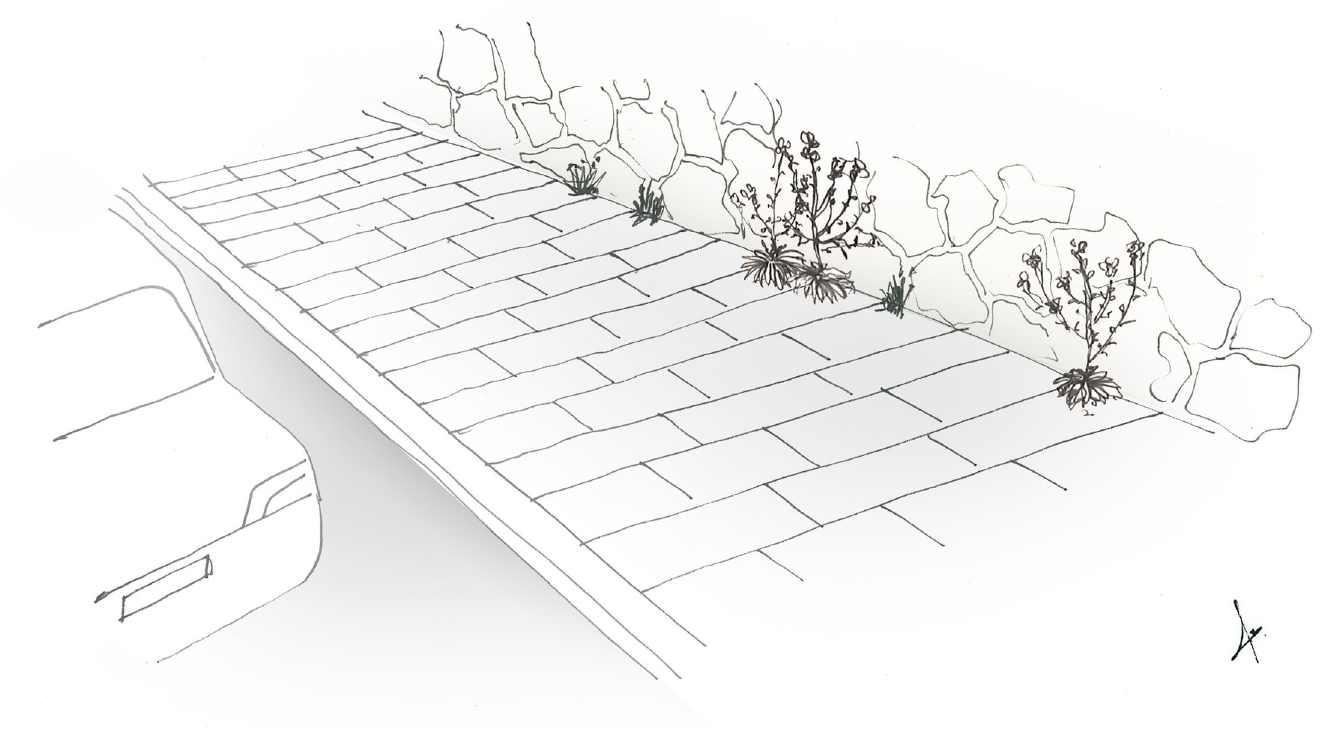
Fig 5. Illlustrated scene for sidewalk functioning as a habitat analogue for M . crassifolia . The cracks in the concrete of the sidewalk due to poor management and the adjacent sandstone wall resemble coastal cliffs occupied by the species. Small and medium-sized therophytes like Plantago coronopus L. abd Polycarpon tetraphyllum are often observed occupying such